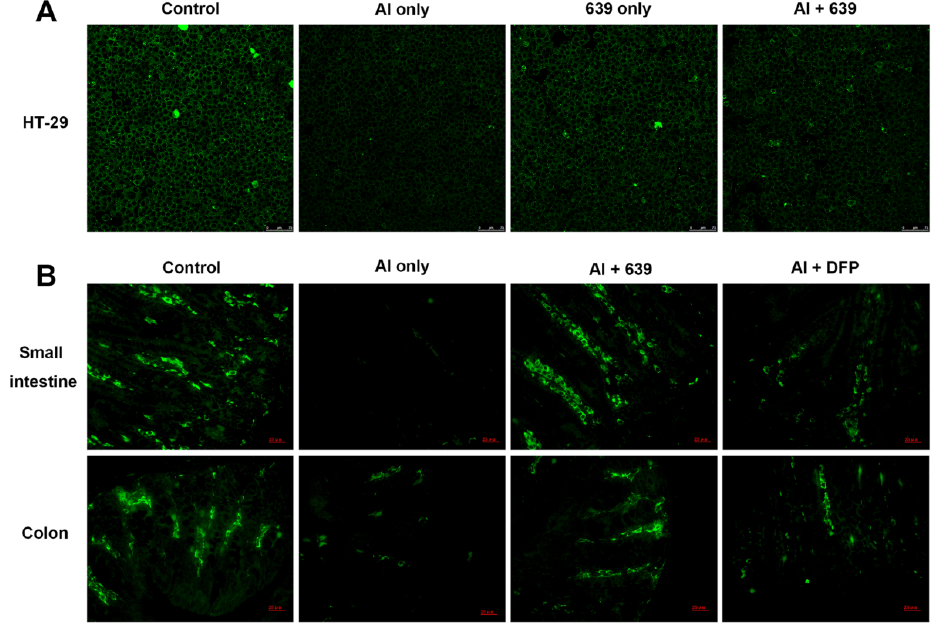
Figure 3. Effects of L. plantarum CCFM639 on Al-induced alterations of tight junction protein occludin: in vitro ( A ); and in vivo ( B ). The occludin levels in HT ‐ 29 cell (therapy assay) and intestine of mice (intervention assay), were observed with confocal microscopy and stained by Alexa Fluor 488 (green).